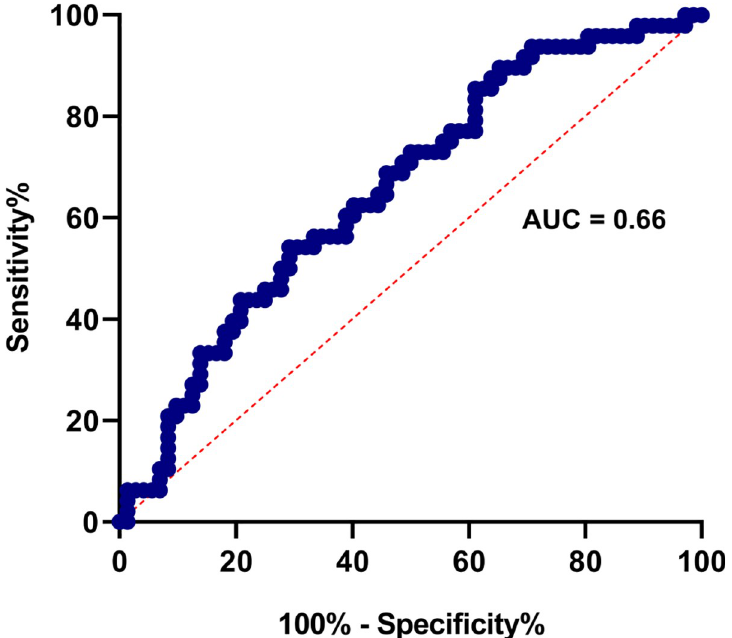
Fig 3. The usefulness of urinary LTE4 as a predictive factor of DHF. Receiver-operator characteristic (ROC) curves showing the area under the curve (AUC) were generated to determine the discriminatory performance of urinary LTE4 in predicting those who will develop DHF during early illness ( � 4 days) in those who progressed to develop DHF (n = 48) or DF (n = 72). Area under the curve AUC = 0.66 and P = 0.0039.